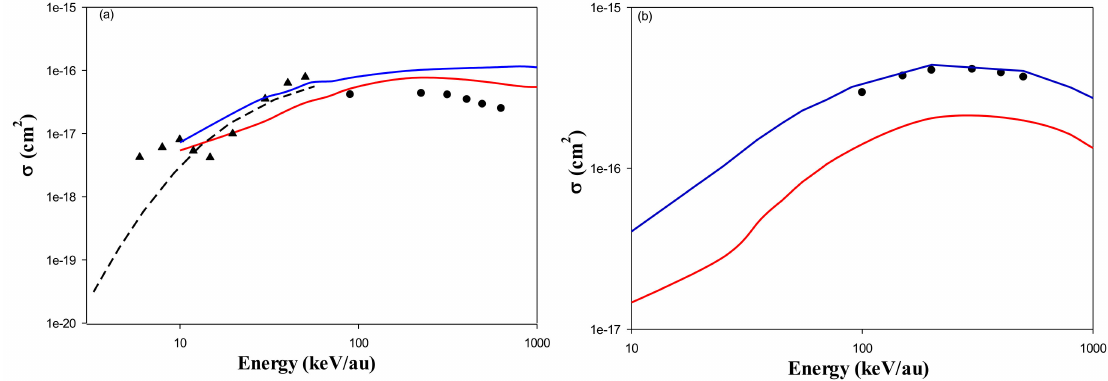
Figure 7. Cross section for the excitation of ( a ) nl = 2 s and ( b ) nl = 2 p hydrogen subshells in Be 4 + + H(1s).collision, as a function of the impact energy. CTMC (solid red line), QTMC-KW (solid blue line), Reference [5] (dash line), Reference [25] ( (cid:78) ), Reference [7] ( •